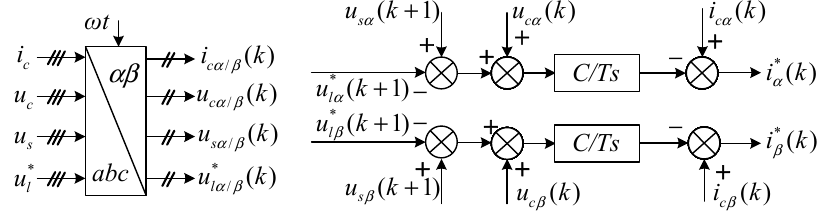
Figure 3. Reference current generation mechanism based on DBDC.